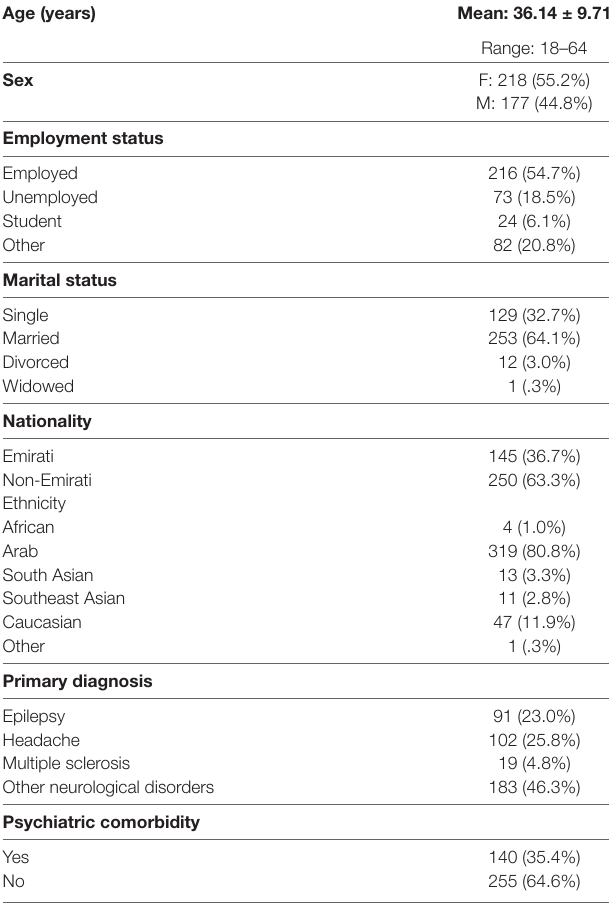
TABLE 1 | Sociodemographic characteristics of the sample ( n =